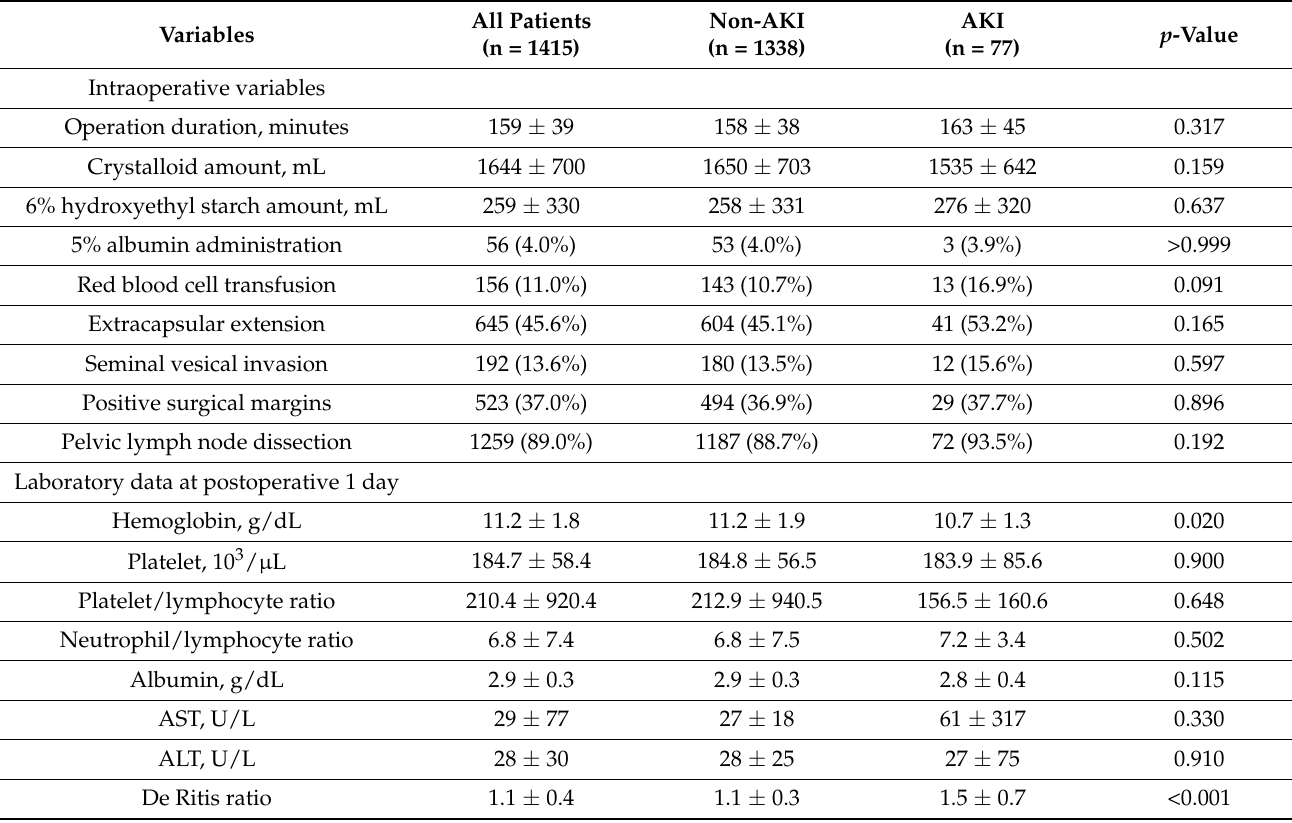
Table 2. Intraoperative variables and laboratory data at postoperative 1